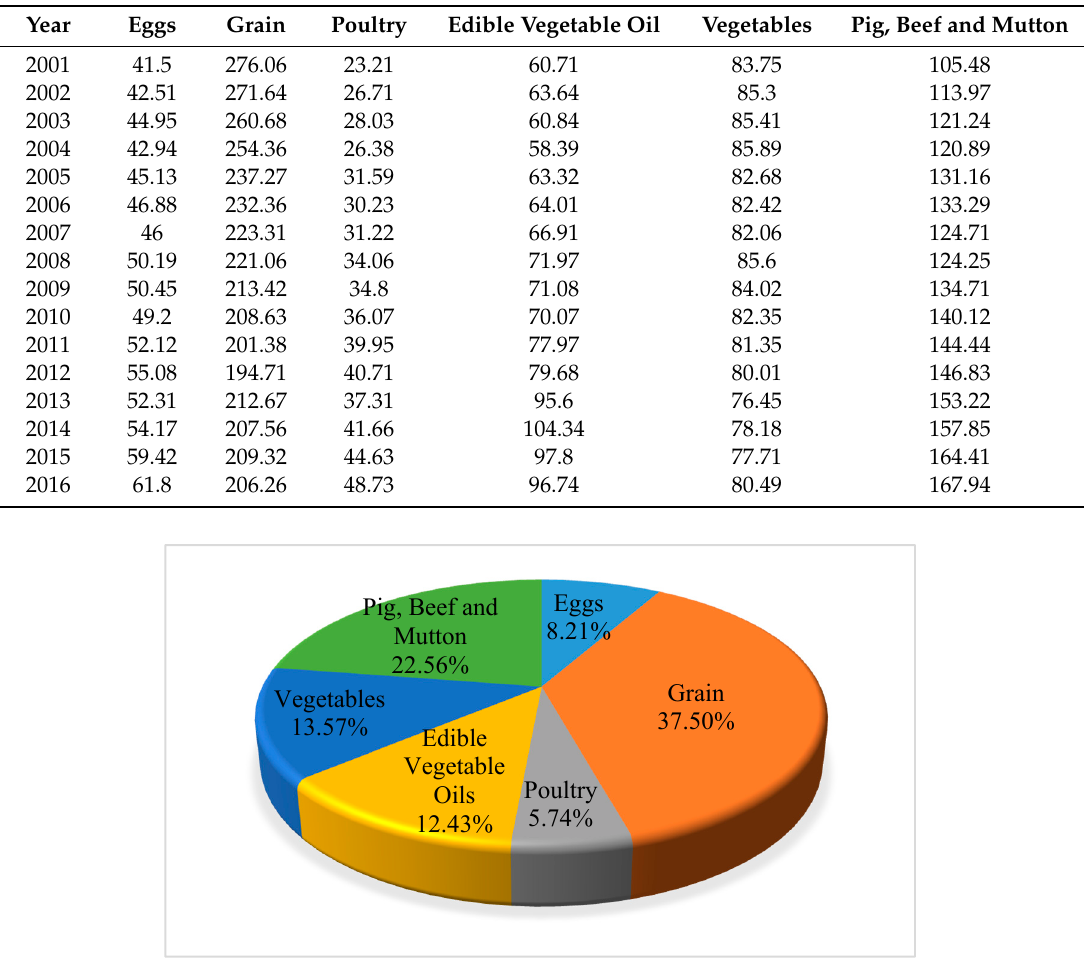
Table 3. Water footprint of residents’ food consumption divided by food types (million m 3 ).